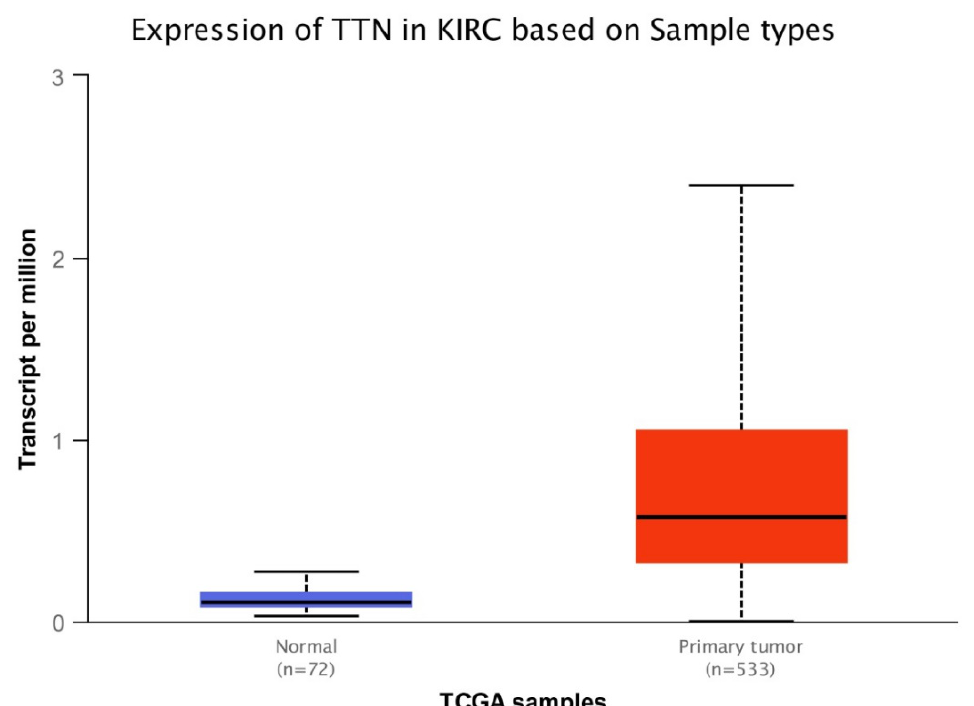
Figure 1. Box-plot analysis showing statistically significant difference ( p < 0.0001) of VHL expression between normal tissue and primary tumor.